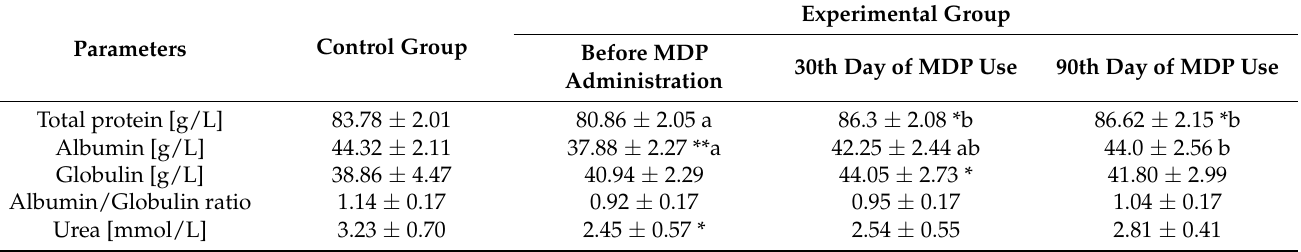
Table 1. Parameters of protein metabolism in the blood serum of cows in the control and experimental groups (Mean ±